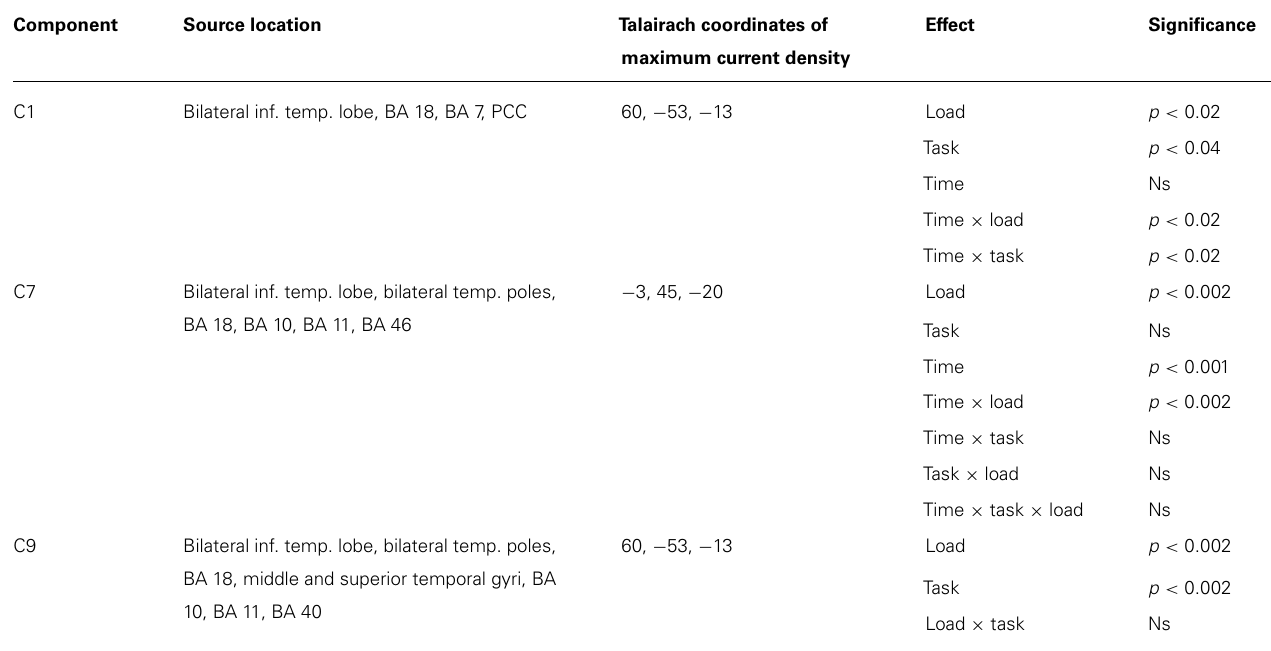
Table 1 | Summary table of components and experimental effects.